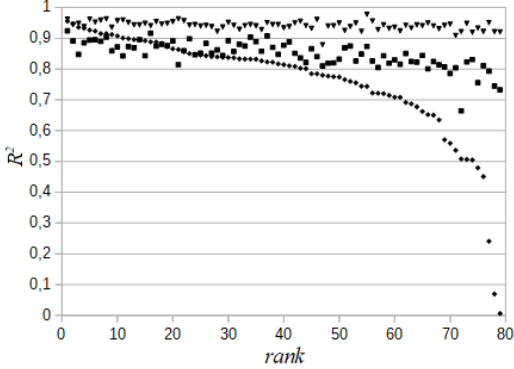
Fig. 4. Results for long model of type